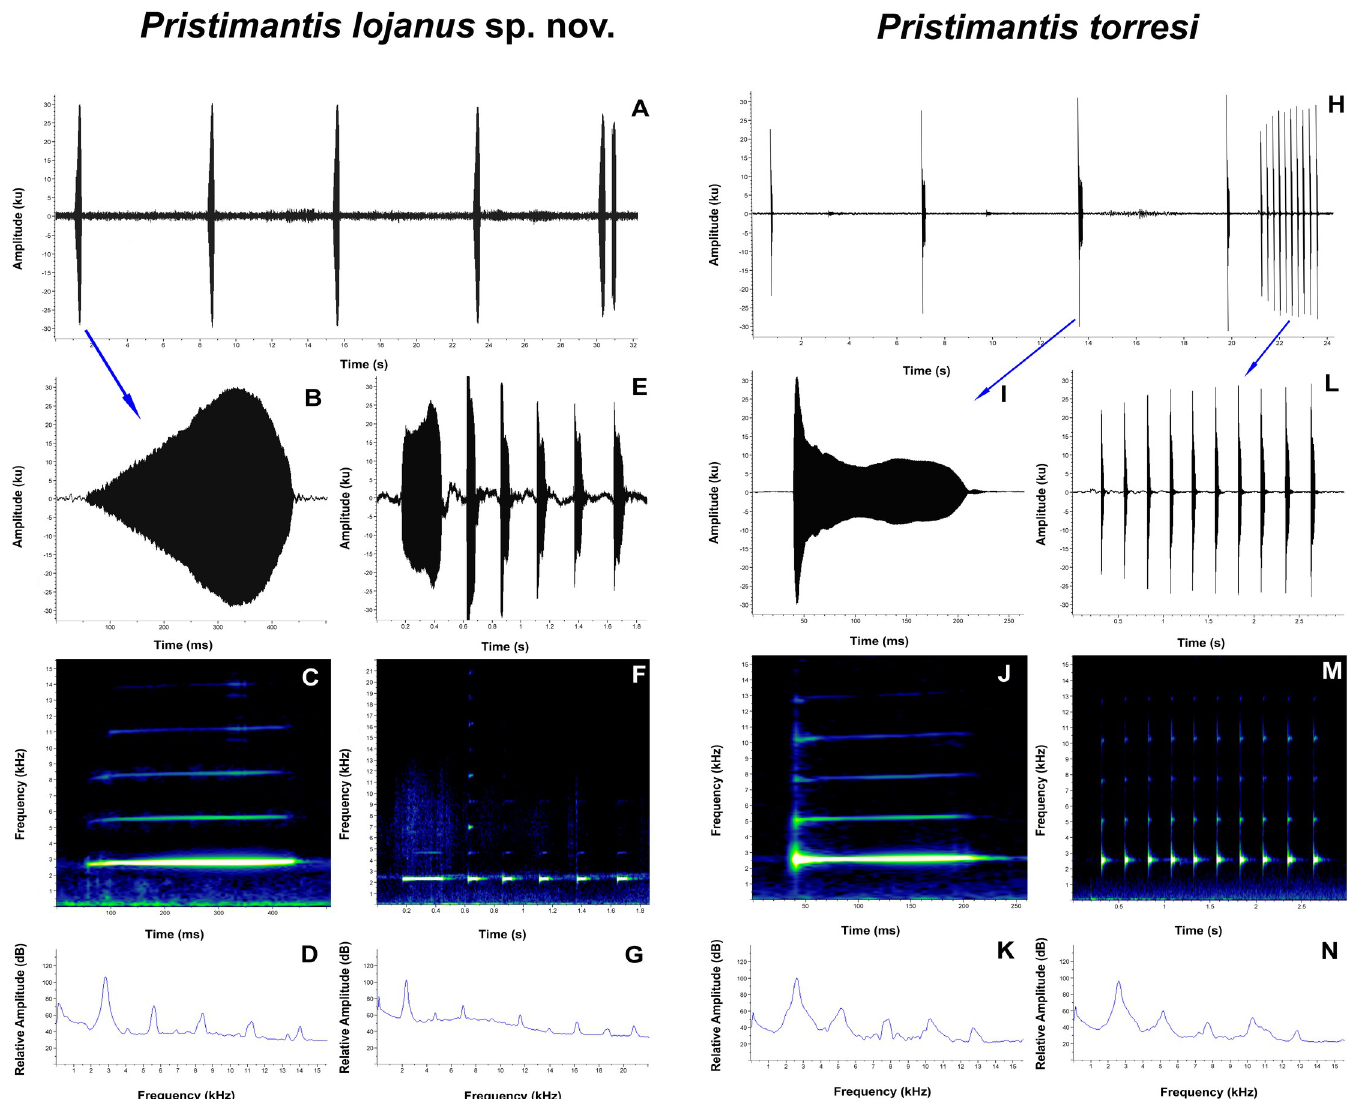
Fig 11. Advertisement calls of Pristimantis lojanus sp. nov. (A–G) and P . torresi (H–N). A. Oscillogram of a 5 calls section of the call series, with single and double- noted (last one) calls; B and I Oscillograms of single-noted calls; C and J Spectrograms of single-noted calls; D and K Power spectrums of single-noted calls; E and L Oscillograms of multi-noted calls; F and M Spectrograms of multi-noted calls; G and N Power spectrums of multi-noted calls; H. Oscillogram of a 5 calls section of the call series, with single and multi-noted (last one) calls; A–D FUTPL-A 252; E–G FUTPL-A 249; H–N MUTPL 996, FUTPL-A 256. All spectrograms at Hanning window function, 512 bands resolution. See text for